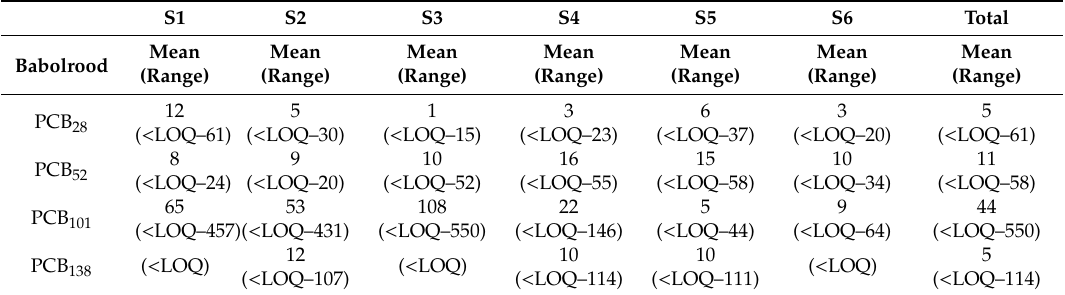
Table 2. Concentrations (ng / L) (mean and range) of POPs in water samples of Babolrood River collected from Iran. LOQ, limit of